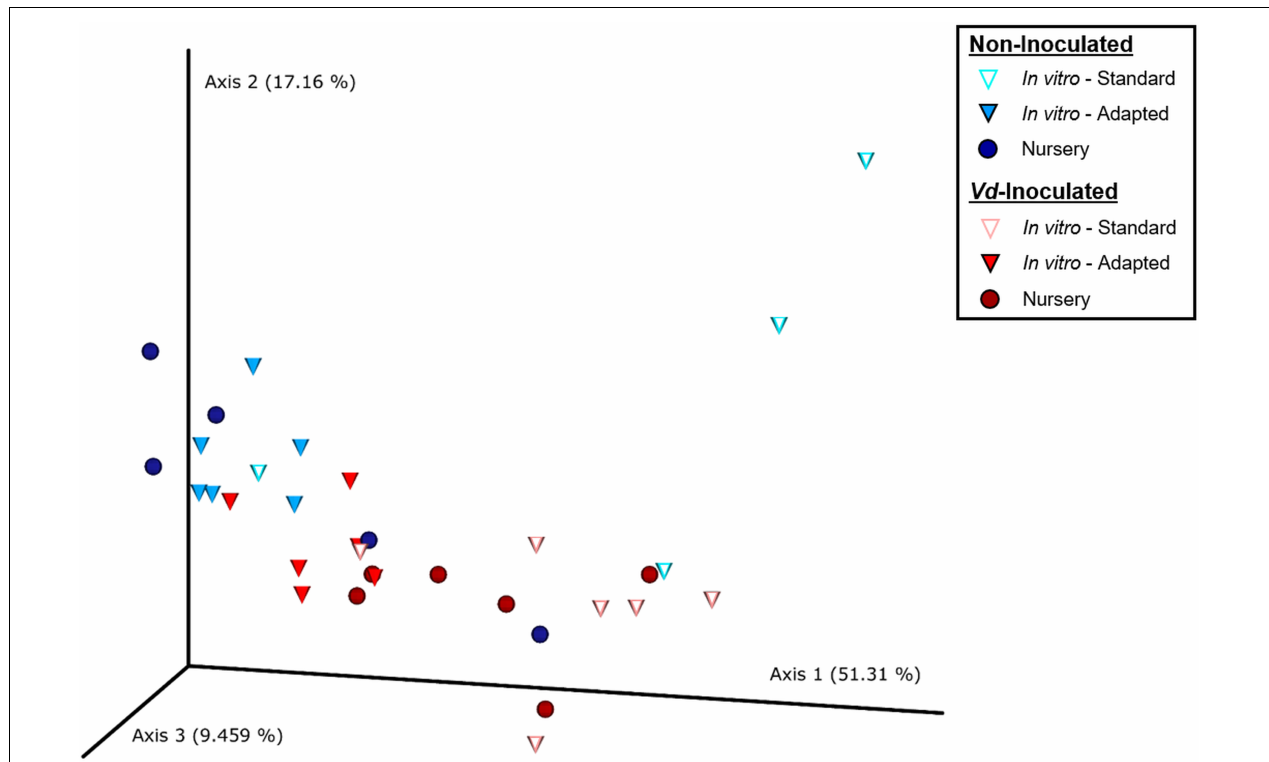
FIGURE 3 | Principal coordinates plot of weighted UniFrac distances of bacterial communities at OTU taxonomic level in olive xylem from Verticillium dahliae ( Vd )-inoculated and non-inoculated “Ac-18” plants following in vitro (standard and adapted) and nursery propagation methods. Points are colored by plant inoculation treatment and shaped by propagation